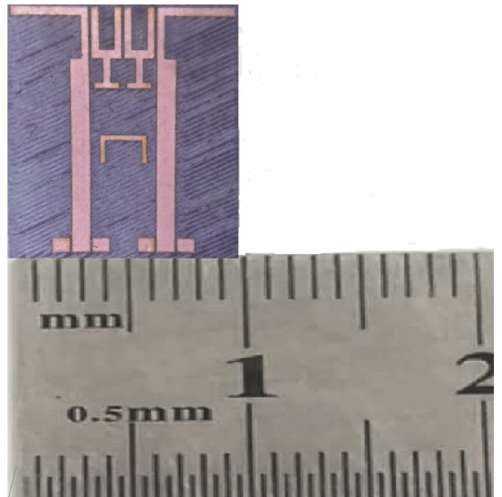
Figure 7: Photographs of this fabricated filter.